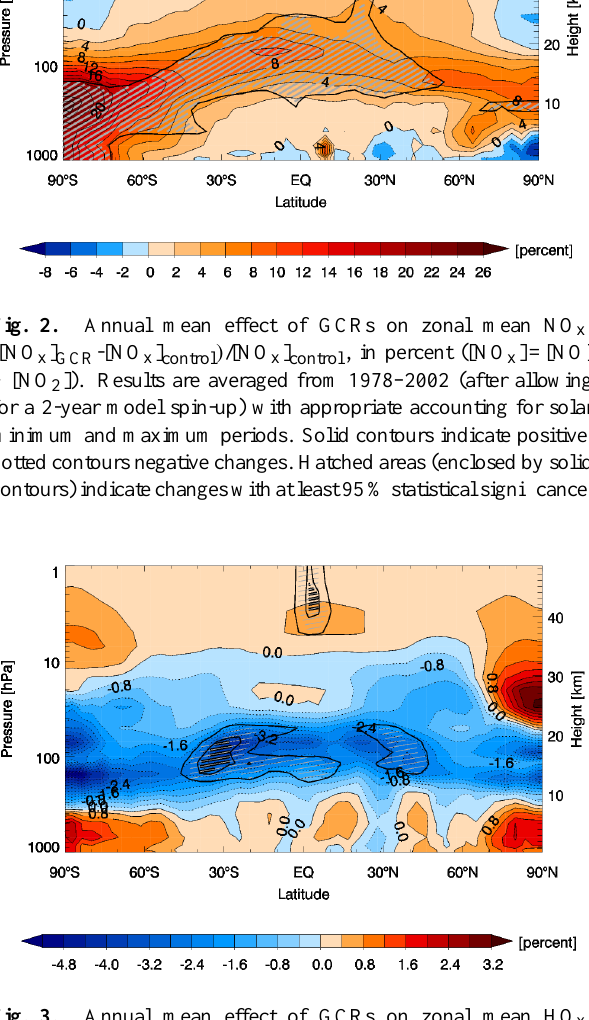
Fig. 3. Annual mean effect of GCRs on zonal mean HO x , ([HO x ] GCR -[HO x ] control ) /[HO x ] control , in percent ([HO x ] = [H] + [OH] + [HO 2 ]). Results are averaged from 1978–2002 (after al- lowing for a 2-year model spin-up) with appropriate accounting for solar minimum and maximum periods. Hatched areas (enclosed by solid contours) indicate statistically significant changes with at least 95% (inner contours) or 80% (outer